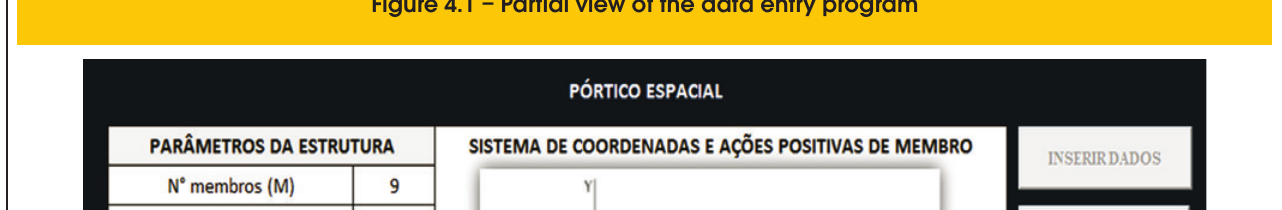
Figure 4.1 – Partial view of the data entry